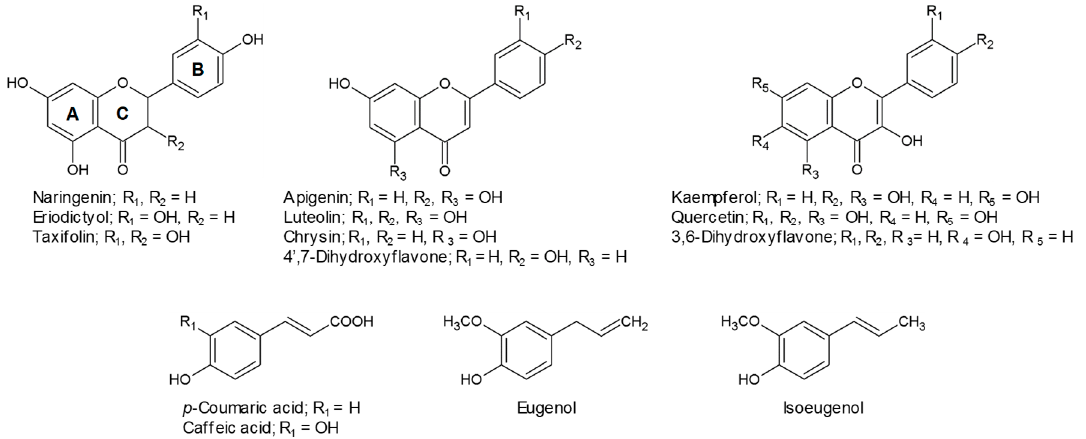
Figure 4. Structures of flavonoid and phenylpropanoid substrates used in the PfOMT3 activity assay. The letters indicate the lettering system for the three flavonoid rings. Molecules 2020 , 25 , x FOR PEER REVIEW